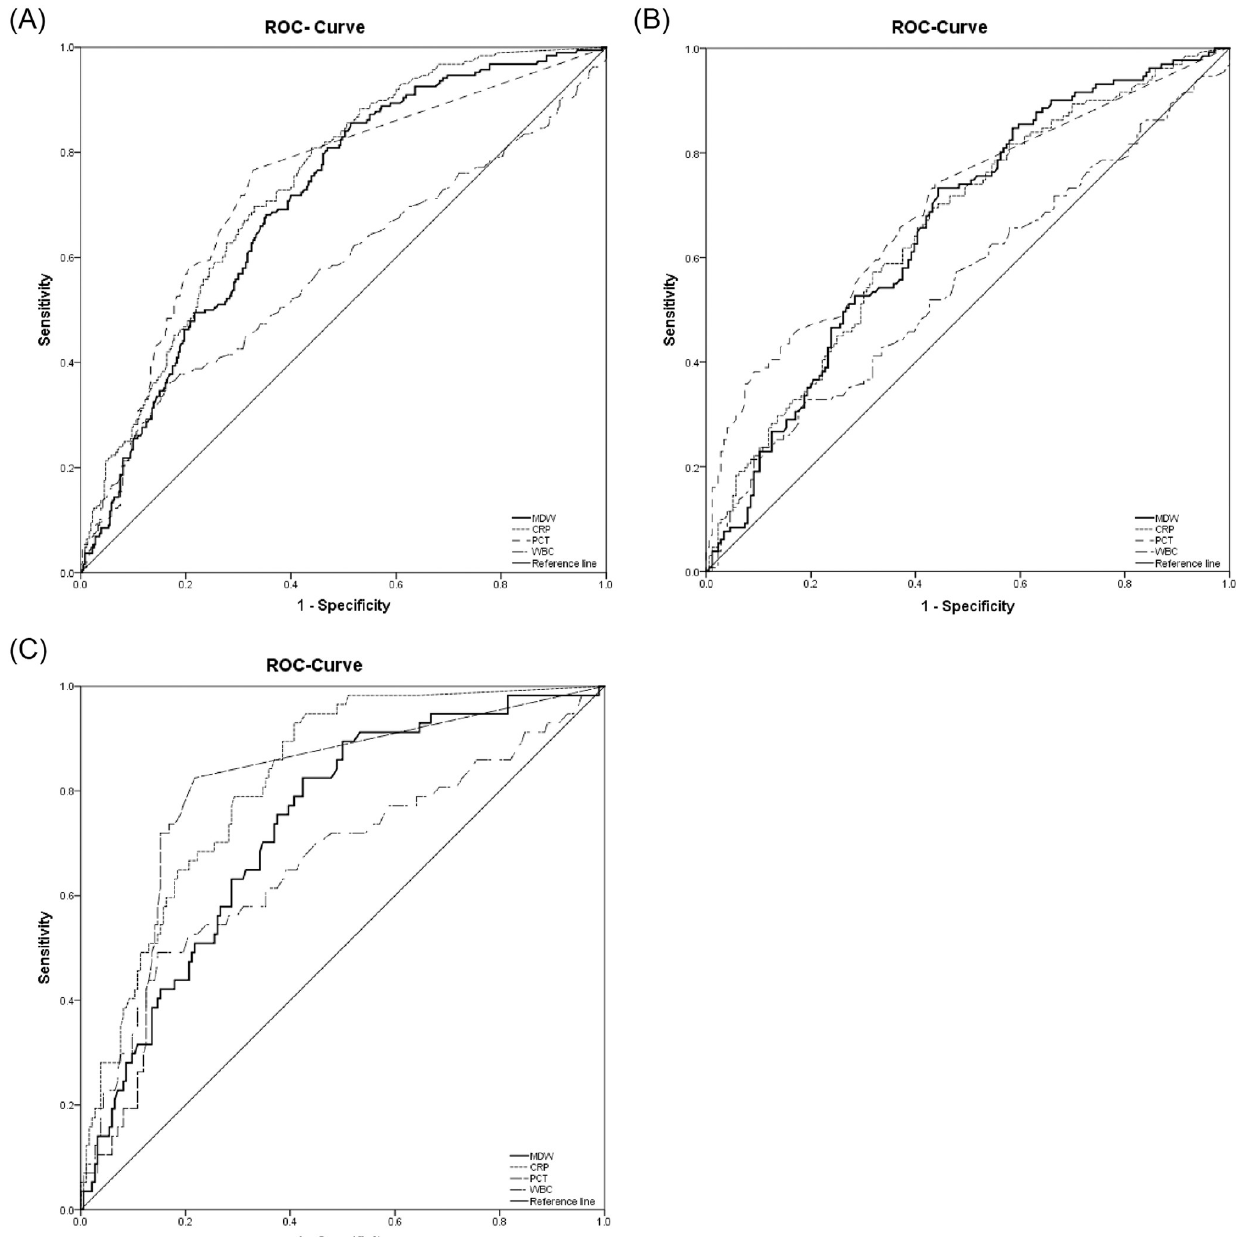
Fig 3. AUC of ROC curve for sepsis prediction, according to immune status. (A) Comparison of AUROC in the overall population. WBC count alone is inferior to other biomarkers. (B) Comparison of AUROC in immune-compromised patients. (C) Comparison of AUROC in immune-competent patients. AUROC is relatively higher in immune-competent patients. ROC, receiver operating curve; AUC, area under the curve; AUROC, area under the curve of receiver operating curve; MDW, monocyte distribution width; CRP, C-reactive protein; PCT, procalcitonin; WBC, white blood cell.